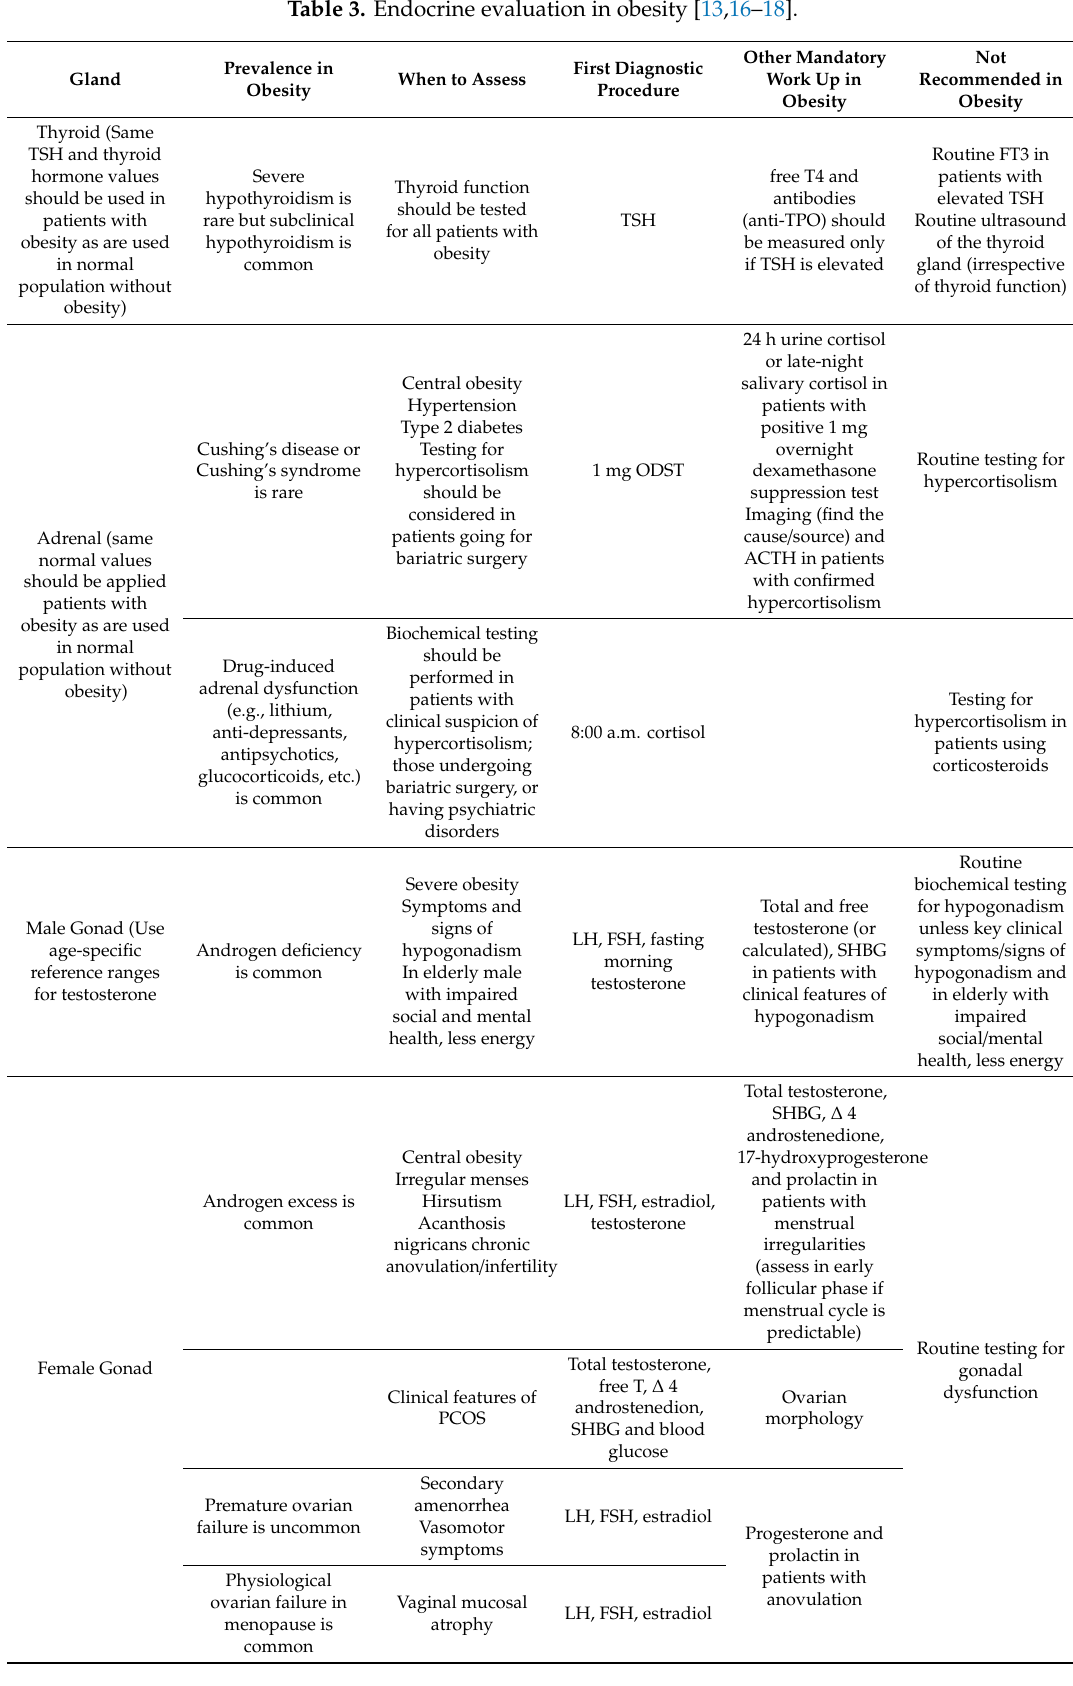
Table 3. Endocrine evaluation in obesity